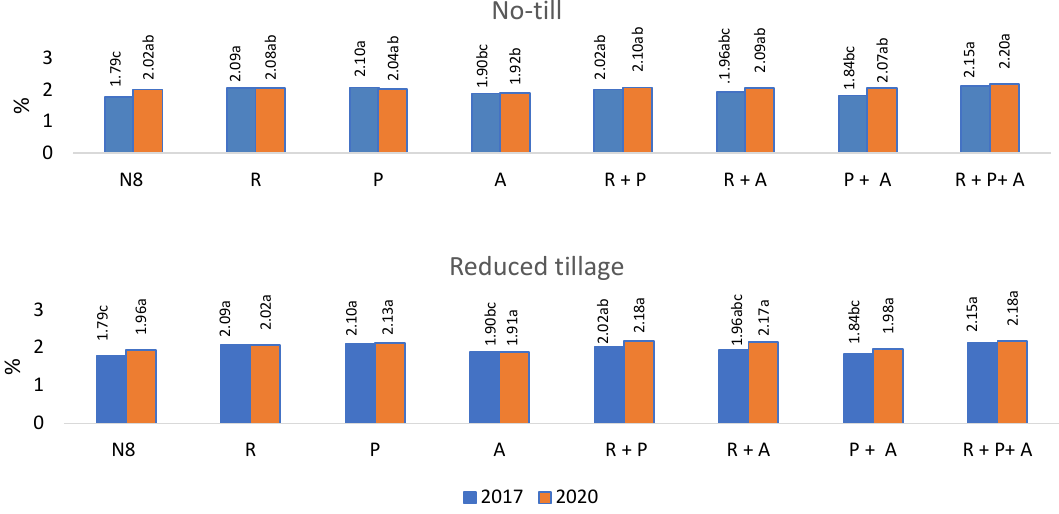
Figure 1. The influence of biostimulants and their mixtures on the humus content in the soil (%) in 2017/2020. N8—compensatory nitrogen at 8 kg per ton of straw, without biological preparations;